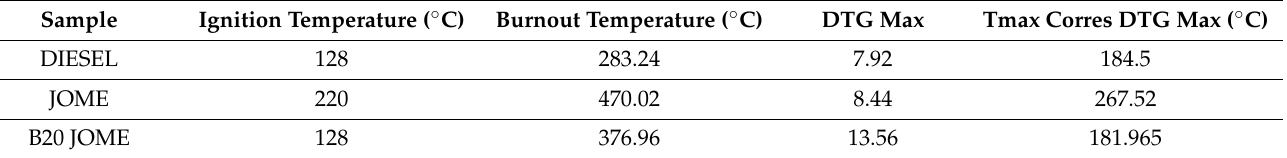
Table 6. Ignition, burnout temperature, DTGmax, and Tmax of diesel, JOME, and B20 JOME.